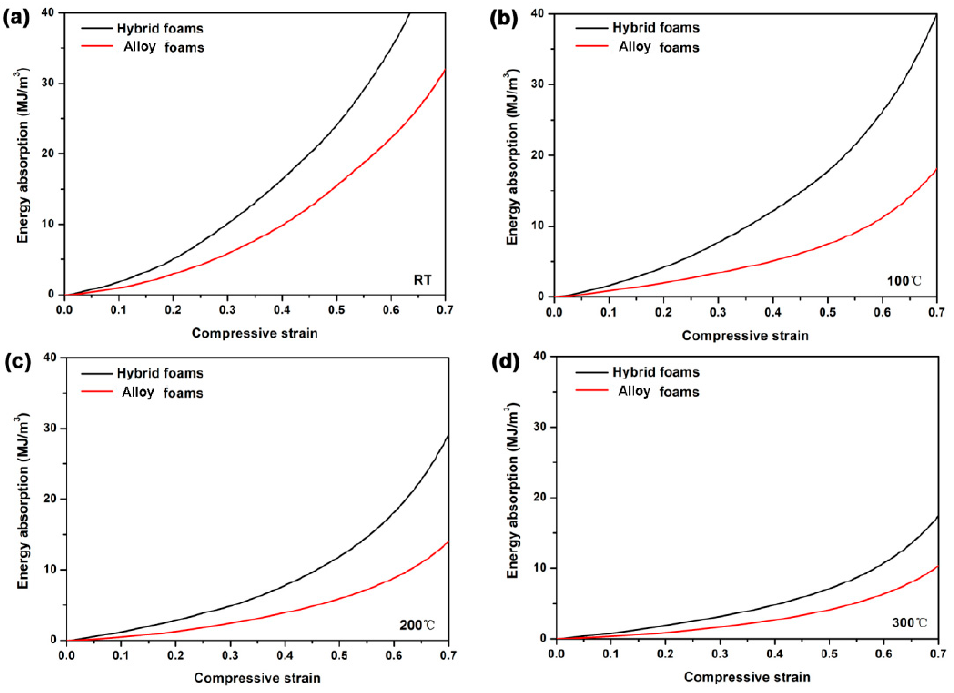
Figure 9. The energy absorption capacities of alloy foams and hybrid foams at: ( a ) RT; ( b ) 100 ◦ C; ( c ) 200 ◦ C; ( d ) 300 ◦